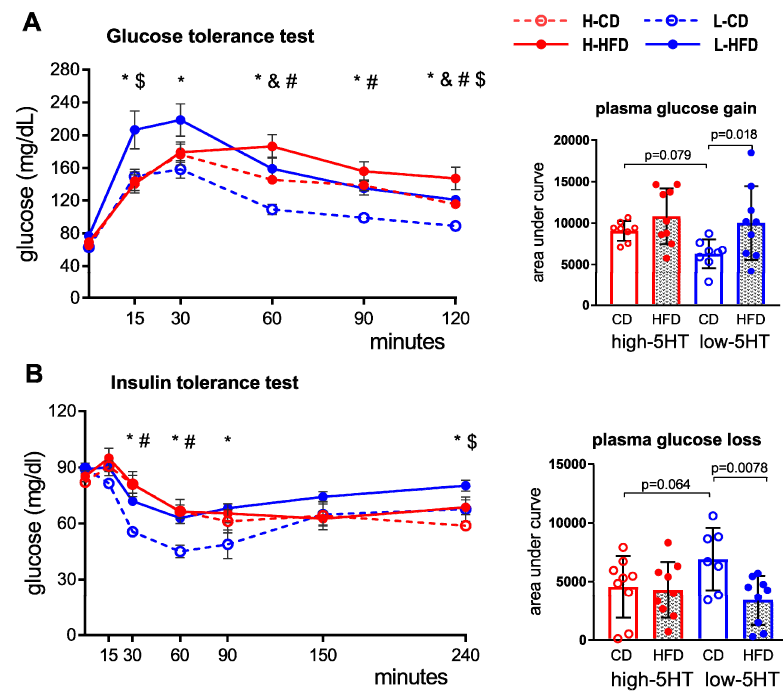
Figure 6. ( A ) Glucose and ( B ) insulin tolerance tests performed in animals from high-5HT and low-5HT sublines after 9 weeks on control diet (CD) or high-fat diet (HFD). The corresponding area under the curve (AUC) are given on the right. Results are presented as means ± SEM (left) or means ± SD (right, AUC) in groups of 9 animals. p -values obtained by LSD or Dunn’s post-hoc test after one-way ANOVA or Kruskal-Wallis test are indicated. H-CD = animals from high-5HT subline on control diet; L-CD = animals from low-5HT subline on control diet; H-HFD = animals from high-5HT subline on high- fat diet; L-HFD = animals from low-5HT subline on high-fat diet; # H-CD vs. L-CD; & H-CD vs. H-HFD; * L-CD vs. L-HFD; $ H-HFD vs.